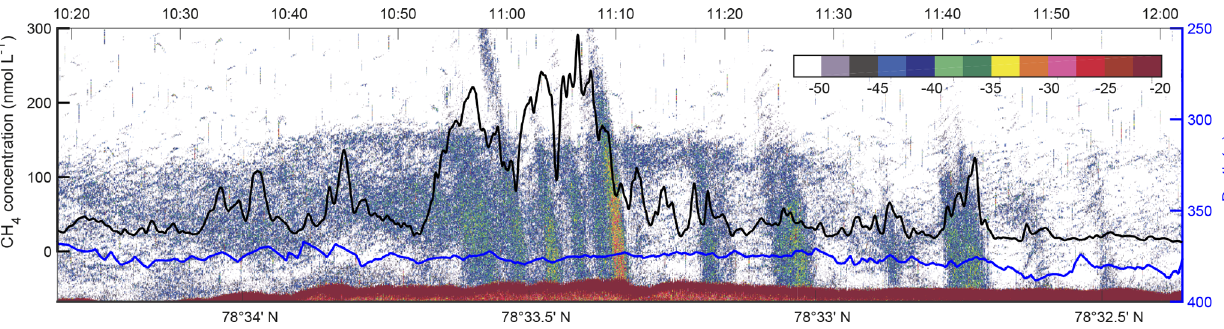
Figure 5. Towed MILS data overlying echo-sounder data. The black line shows the CH 4 concentration along line 3 (see Fig. 1 for location) at ∼ 15m from the seafloor. The blue line indicates the depth of the probe. The echogram, displaying target strength values (colour bar shows intensity – dB) from the 38kHz channel of the EK60, is shown in the background.